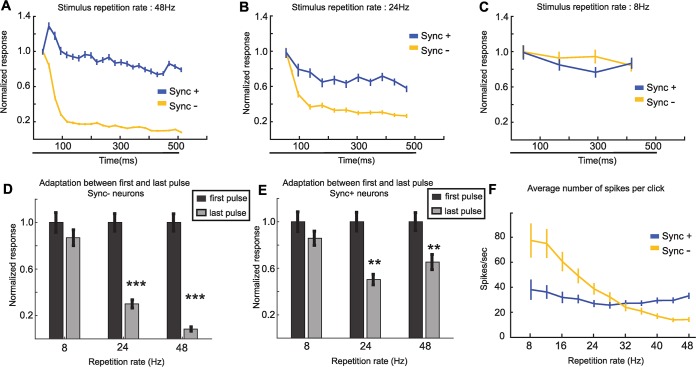
Event-related activity of monotonic Sync neurons.(A-C.) Normalized number of spikes at each acoustic event for real Sync- (n = 26) and Sync+ (n = 25) neurons at 48Hz (a.) 24Hz (B.) and 8Hz (C.). Each data point was calculated by averaging the number of spikes at the time of each acoustic event (with response latency considered). Error bars indicate s.e.m. Black bar indicates stimulus presentation period. (D-E.) adaptation between first and last acoustic event of stimulus for Sync- (D.) and Sync+ (E.) neurons. (D.) adaptation at 8Hz (Wilcoxon rank sum test, P = 0.1), 24Hz (Wilcoxon rank sum test, P << 0.001), 48Hz (Wilcoxon rank sum test, P << 0.001). (E.) adaptation at 8Hz (Wilcoxon rank sum test, P = 0.71), 24Hz (Wilcoxon rank sum test, P = 0.01), 48Hz (Wilcoxon rank sum test, P = 0.03). (F.) Average number of spikes of real Sync+ and Sync- neurons at each acoustic event across different repetition rates. Sync+: Spearman correlation coefficient = 0.36, P = 0.36; Sync-: Spearman correlation coefficient: 0.99, P <0.001.